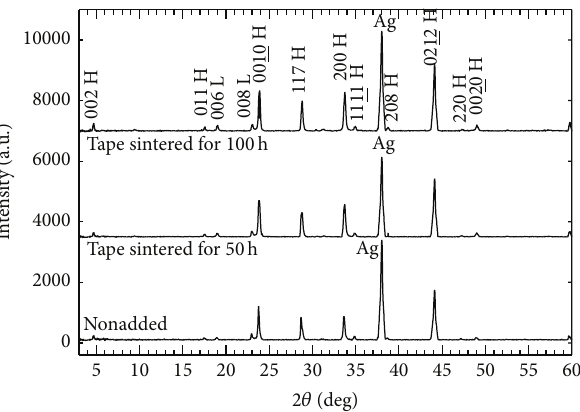
Figure 2: XRD patterns of nonadded and NiF 2 nanoparticle added tapes sintered for 50 and 100 h. (H) denotes the high- 𝑇 𝑐 phase (Bi- 2223) and (L) denotes the low- 𝑇 𝑐 phase